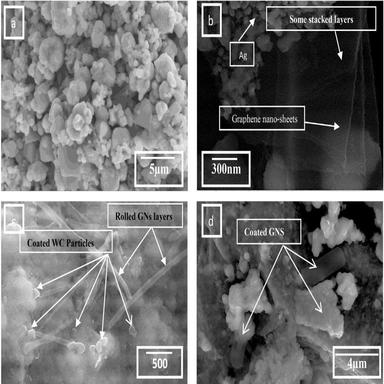
SEM micrographs of (a) WC-TiC-Co, (b) Graphene nano-sheets coated with silver, and (c, d) WC-TiC-Co/1 wt% GNs coated with copper.